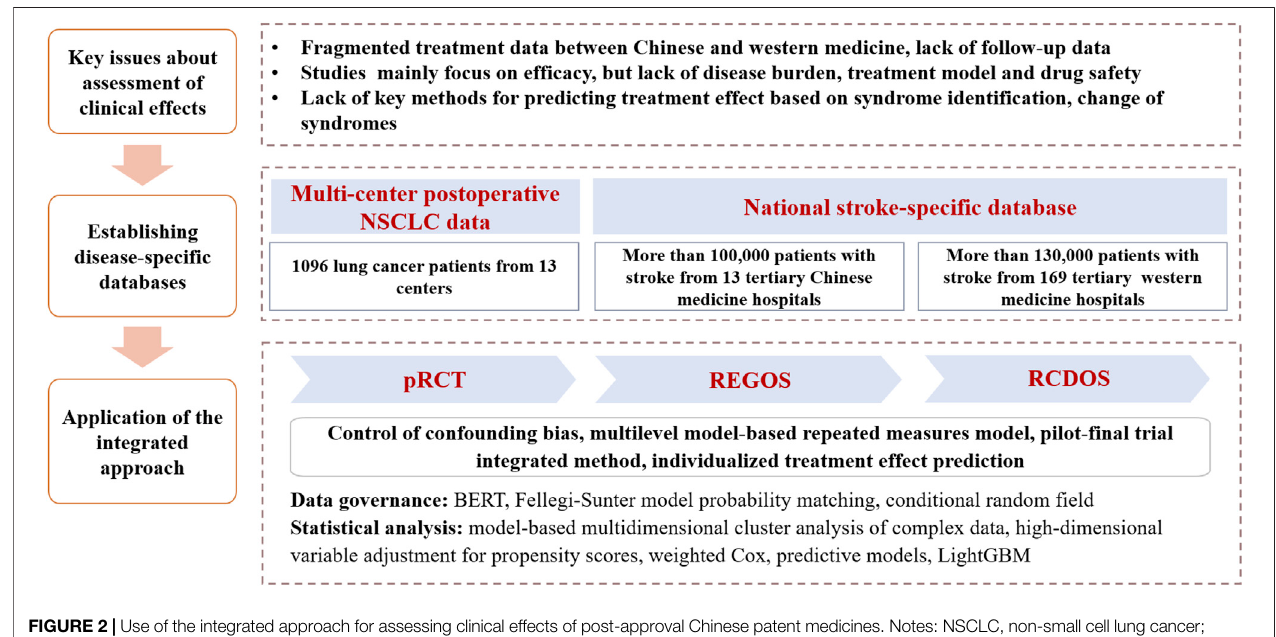
FIGURE 2 | Use of the integrated approach for assessing clinical effects of post-approval Chinese patent medicines. Notes: NSCLC, non-small cell lung cancer; pRCT, pragmatic randomized controlled trial; REGOS, observational studies using patient registry data; RCDOS, observational studies using routinely collected data.